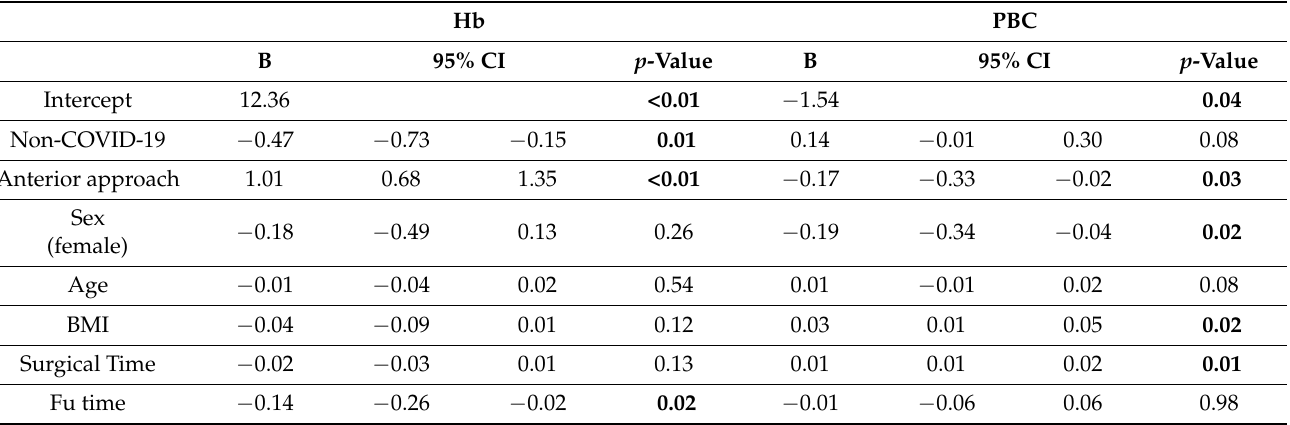
Table 10. Multiple linear regression models for anemia (PBC: packet blood cells; Fu: follow up; BMI: Body Mass